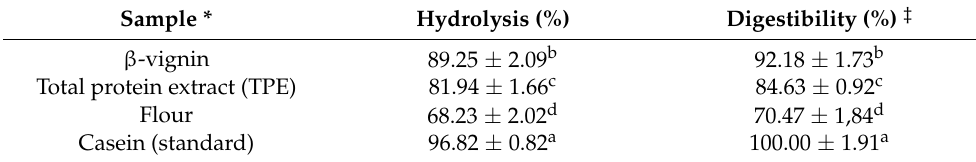
* Values represent means ± standard deviation of tests performed in triplicate. Different superscript letters mean statistical differences for P < 0.05 (ANOVA) by Turkey’s multiple-range test. ‡ Percentage relative to